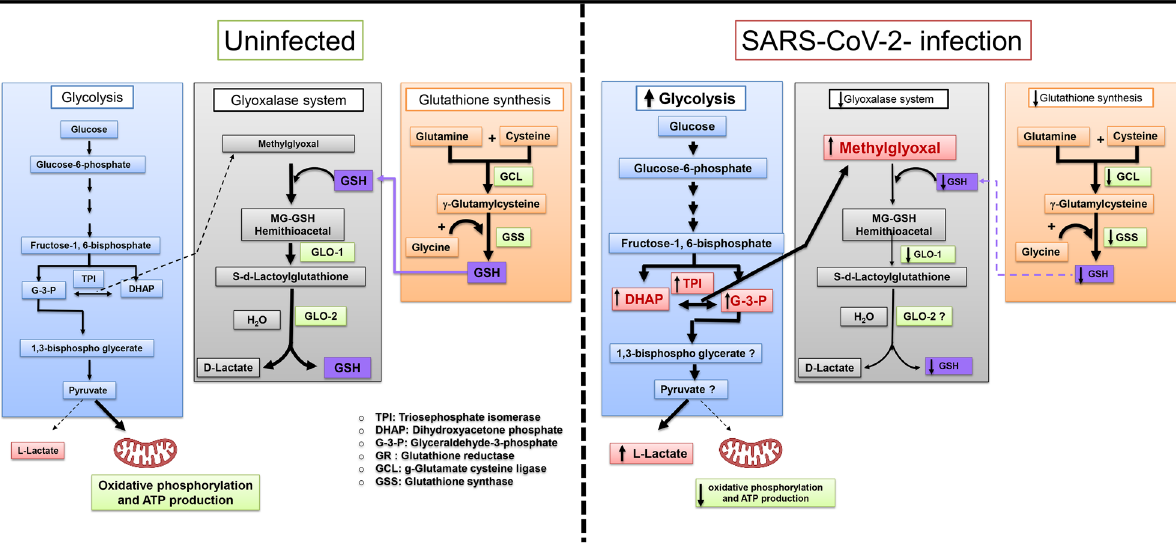
Figure 12. Overview of methylglyoxal (MG)formation via glycolysis and the degradation of the methylglyoxal- glutathione hemiacetal in uninfected and SARS-CoV-2 infected individuals. MG is formed from the interconversion of the dihydroxyacetone phosphate (DHAP) and glyceraldehyde-3-phosphate (G3P) via triosephosphate isomerase that generates MG. MG is detoxified by the dual-enzyme glyoxalase system. In the first step, the rate-limiting glyoxalase 1 (Glo1) converts the hemithioacetal formed between MG and reduced glutathione (MG-GSH) to the thioester S-d-lactoylglutathione. In the second step glyoxalase 2 (Glo2) enzyme catalyzes the hydrolysis of S-d-lactoylglutathione to form d-lactate. During this reaction, GSH is recycled. Following SARS-CoV-2 infection, glycolysis is upregulated in the infected cells and host immune cells. At the same time, Glo1 and GSH are down regulated, resulting in cytotoxic levels of